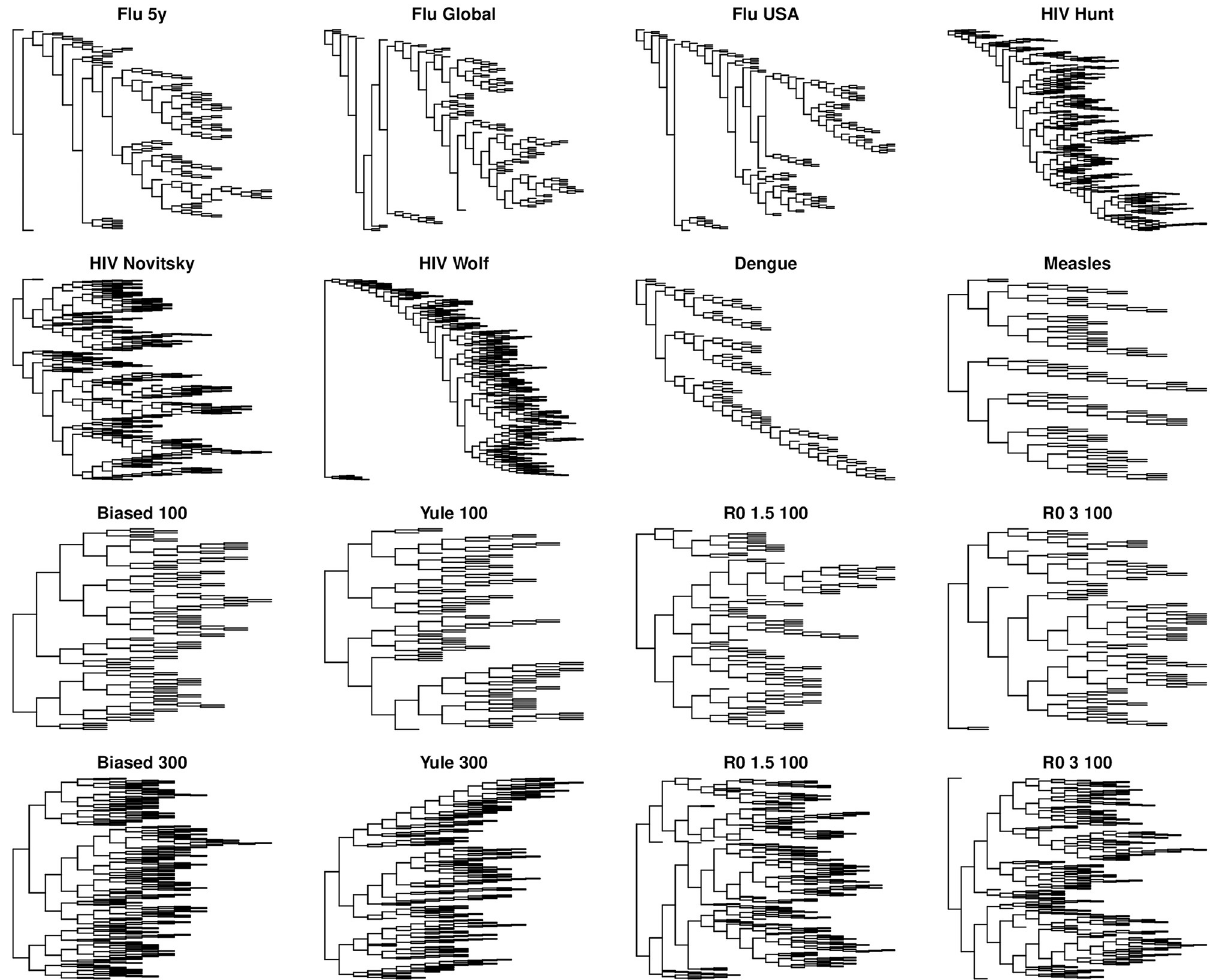
Fig 4. A randomly sampled tree from each scenario (except HIV in the 3-virus comparison because HIV is represented in three other trees). To allow for focus on tree shape rather than on branch lengths, trees have been visualized with branch lengths set to 1.